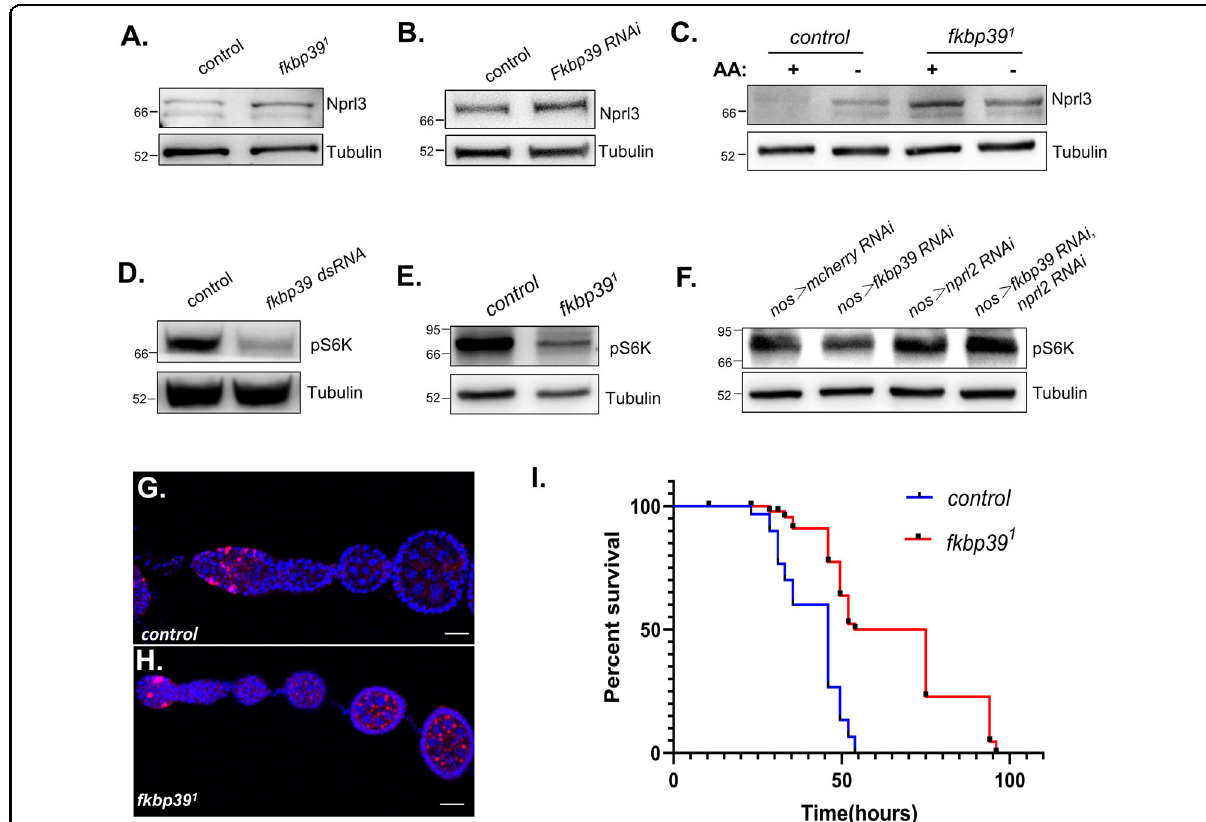
Fig. 5 FKBP39 increases TORC1 activity in vivo. A Western blot analysis of Nprl3 protein in the ovaries of yw (control) and fkbp39 1 . B Western blot analysis of the Nprl3 protein expression in the ovaries of MTD > mCherry RNAi (control) and MTD > fkbp39 RNAi fl ies. C The ovaries from yw (control) and fkbp39 1 were dissected and cultured in amino-acid-free Schneider ’ s medium (AA-) for 2 h. The levels of Nprl3 were detected by western blot. D Western blot analysis of phosphorylated S6K in the GFP (control) or fkbp39 dsRNA treated S2 cells. E Western blot analysis of phosphorylated S6K in the ovaries of yw (control) and fkbp39 1 . F Western blot analysis of phosphorylated S6K in the ovaries of nos > mCherry RNAi (control), nos > fkbp39 RNAi, nos > nprl2 RNAi and nos > fkbp39 RNAi, nprl2 RNAi fl ies. G – H The ovaries from yw (control) and fkbp39 1 were dissected in cell culture media and stained with Hoechst and LysoTracker Red. Bar, 20 μ m. I Three days old yw ( n = 30) and fkbp39 1 ( n = 44) fl ies were cultured with complete starvation media (1% Agar in PBS). Survivors were counted at the indicated time points. Pairwise comparisons by the Mantel-Cox log rank test showed P < 0.001. α -Tubulin was used as a loading control for western blot. Similar western blot results were observed in more than three independent experiments for each